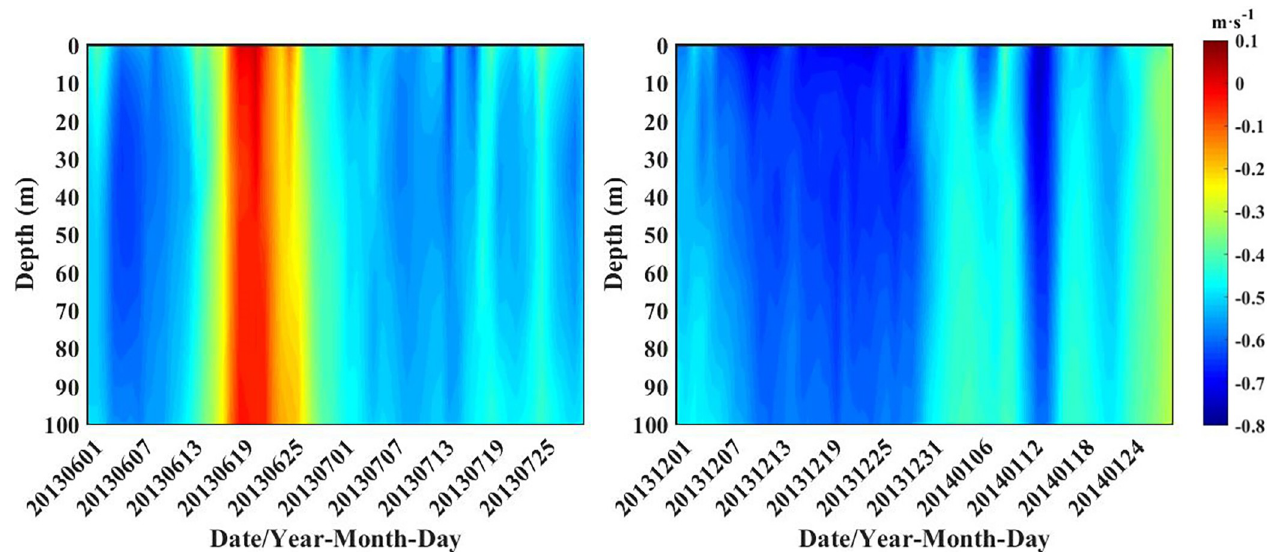
Fig 5. The flow rate of the Agulhas Current through line C.